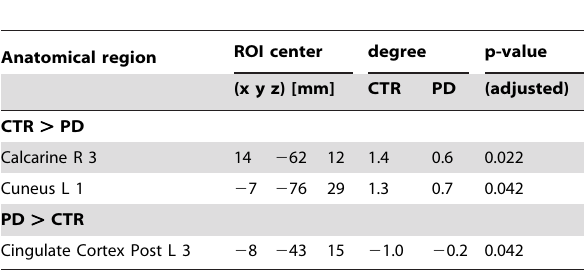
Table 2. Nodes showing the strongest between group effects in degree centrality.